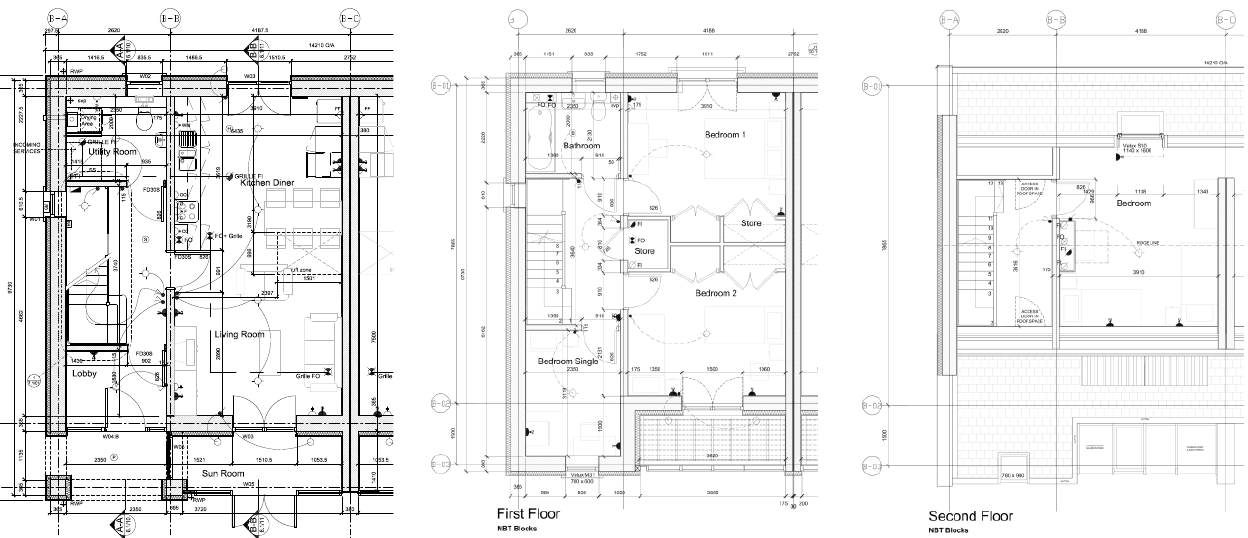
Figure 2. Floor plans.